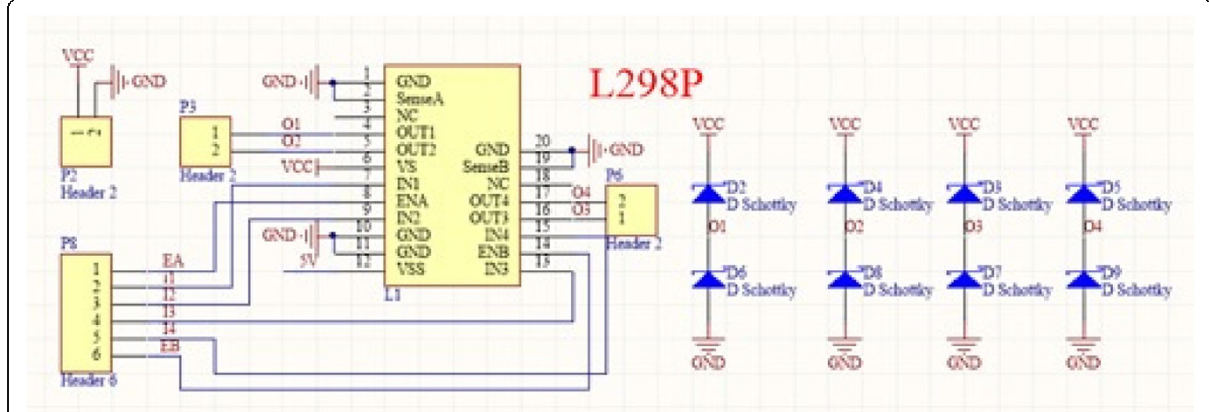
Fig. 26 Driving circuit of the L298P